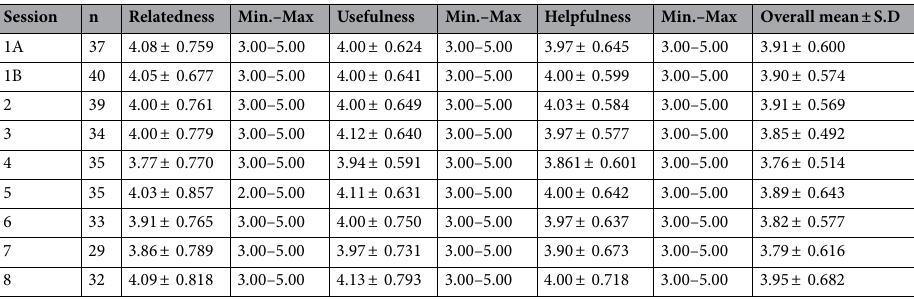
Table 8. Satisfaction survey of each